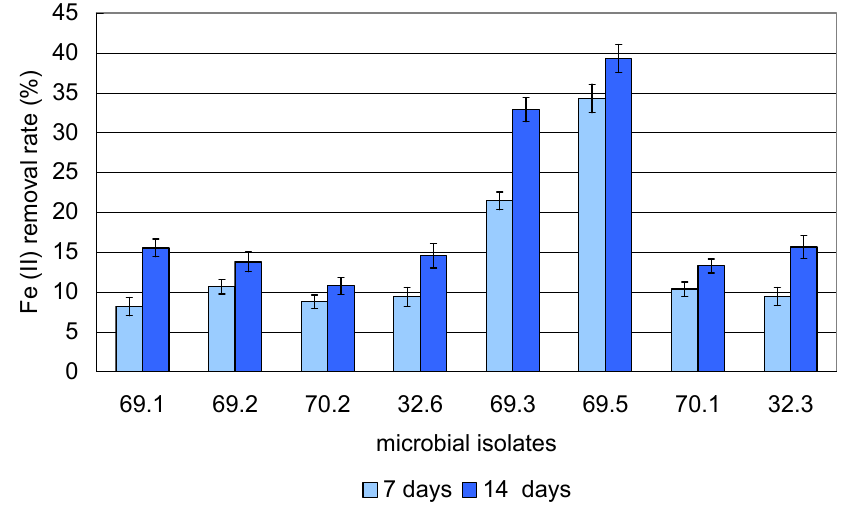
Figure 2. Fe (II) removal by the studied microorganisms (mean ± S.D., n = 9; p ≤ 0.05).